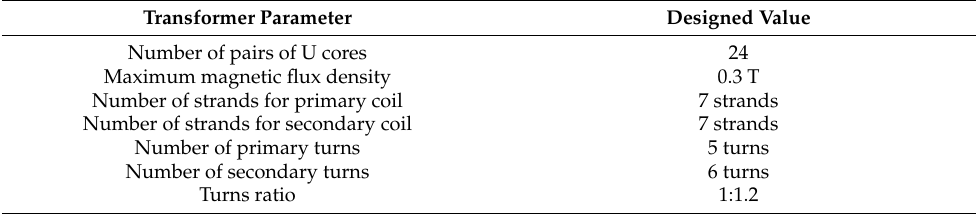
Table 6. Design outcomes of the prototype HF transformer.